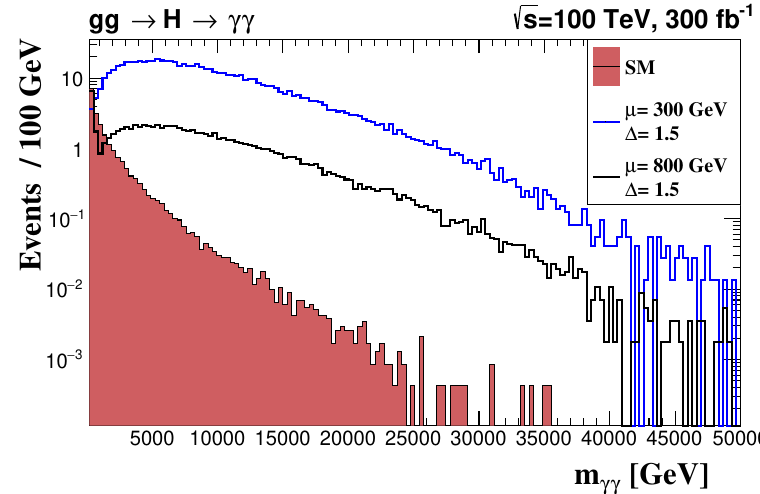
Figure 16. gg ! (cid:13)(cid:13) at 100 TeV center of the mass energy with 300 fb (cid:0) 1 integrated